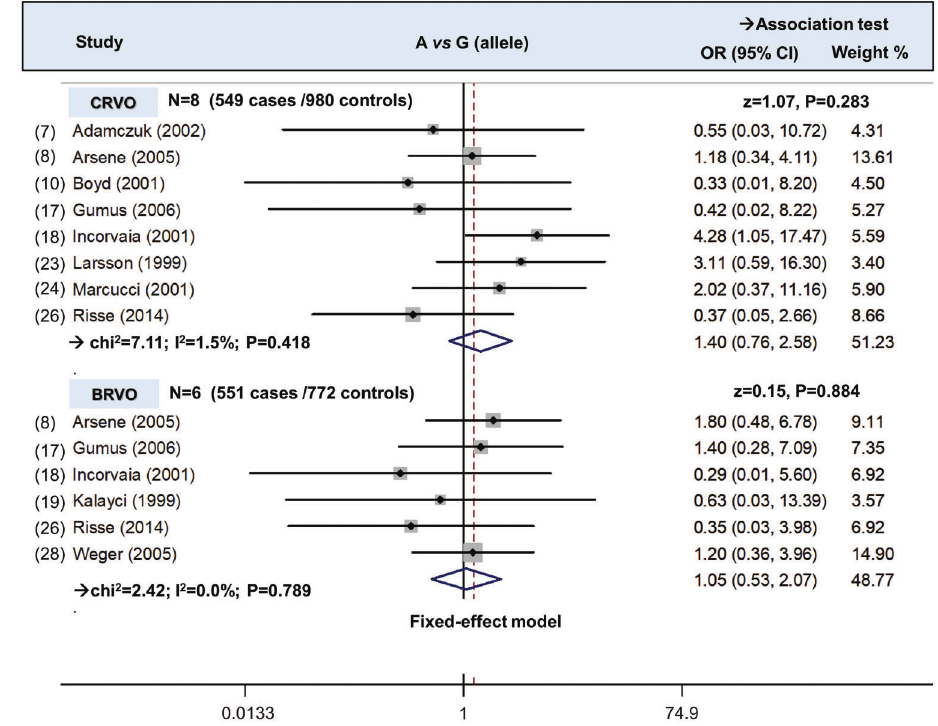
Figure 3. Subgroup analysis according to RVO type under the A vs G (allele) model. CRVO: central retinal vein occlusion; BRVO: branch retinal vein occlusion; OR: odds ratio; CI: con fi dence internal; N: study